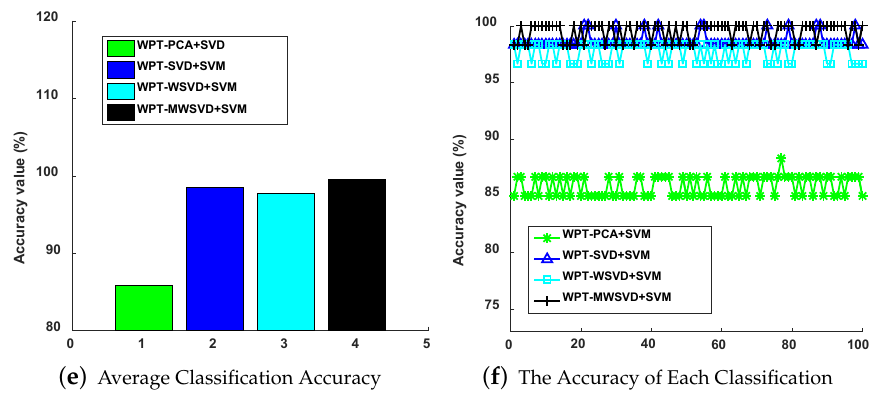
Figure 15. The degree of fault is minor fault ( a ), general fault ( c ) and serious fault ( e ); The degree of fault is minor fault ( b ), general fault ( d ), and serious fault ( f ).